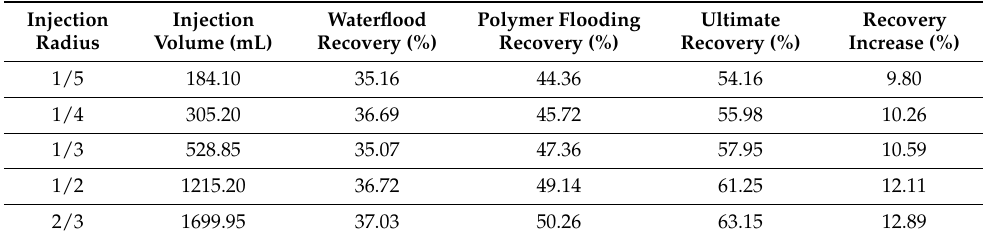
Table 5. The recovery degree of different profile control radius at each